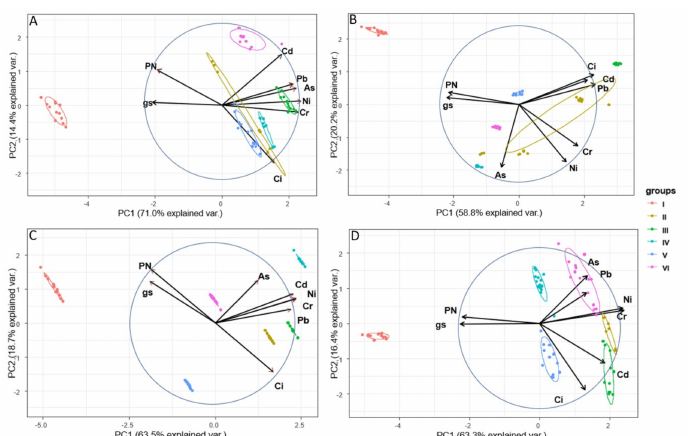
Figure 5. Principal component analysis of photosynthetic activity parameters and trace elements concentrations (arrows) and samples from each exposure sites (points) in four exposure series ( A – D , respectively). Ellipses represent the confidence intervals of points.